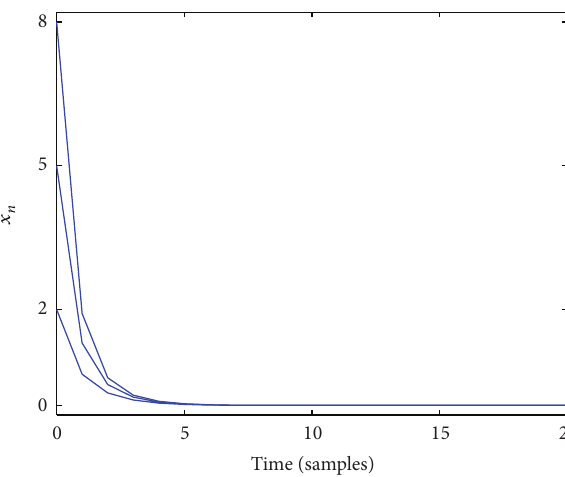
Figure 2: Upper-bounding of the convergence rate of iteration.